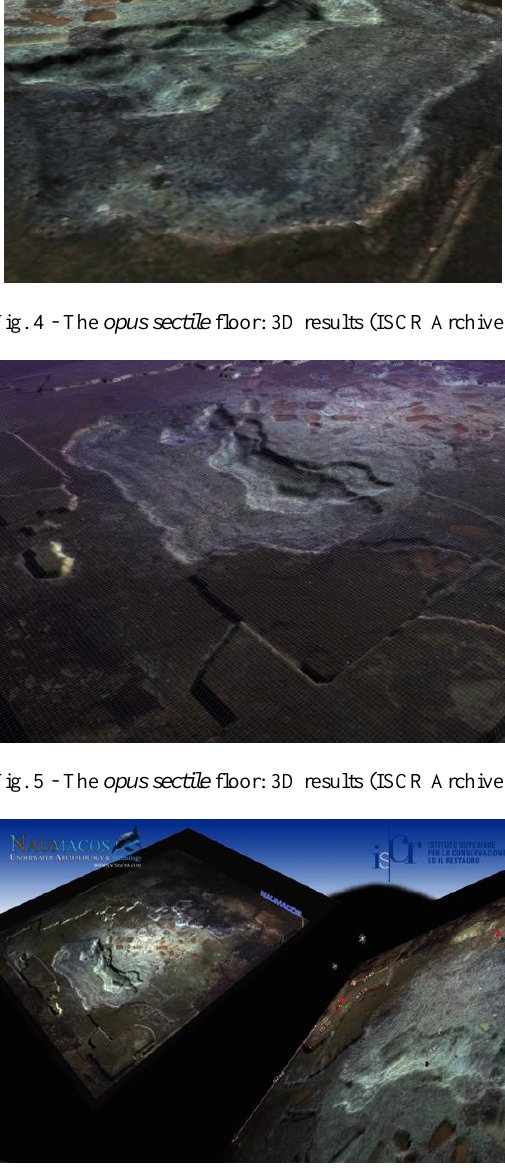
Fig. 6 - The opus sectile floor: 3D results (ISCR Archive) In another phase of development, a portable scanning system was developed, based on infrared laser light structured. The system is operated by the diver simply framing the area to be scanned as a video camera. It can also be placed in front of the area to be scanned and activated, the system begins scanning rotating on its axis (Fig. 8).